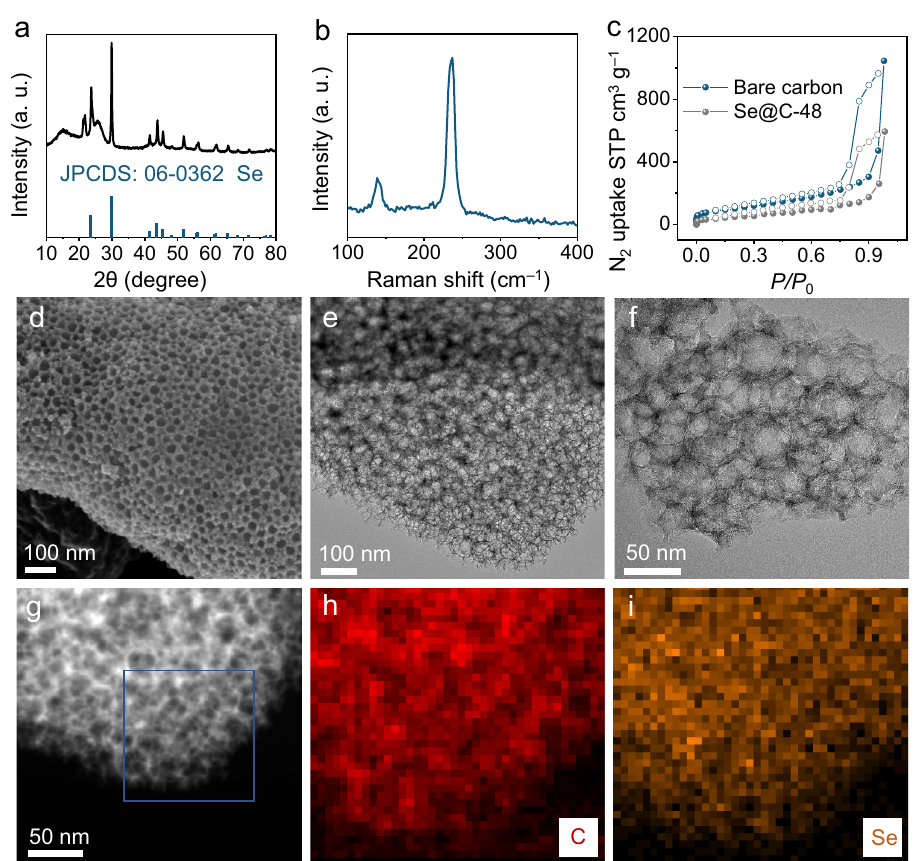
Fig. 1 Physicochemical characterizations of the Se@C-48 composite. a XRD pattern, b Raman spectrum, and c N 2 adsorption-desorption isotherm of Se@C-48 composite. The d FESEM, e , f TEM images, and g – i corresponding element mappings of the Se@C-48 composite.